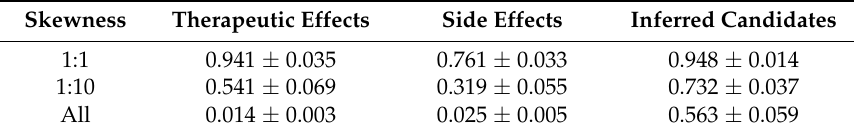
Table 4. Precision performance of the method, which uses molecular network analysis and ethnopharmacological use evidence in predicting therapeutic effects, side effects and potential candidate effects.